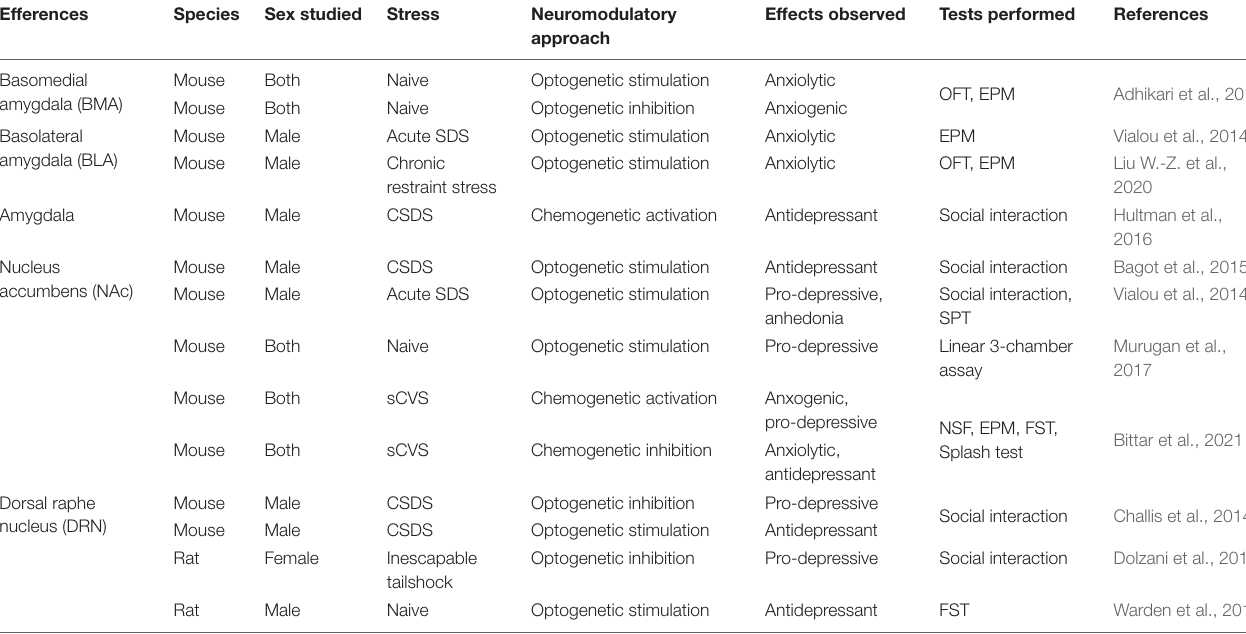
TABLE 2 | Overview of preclinical studies involving mPFC efferences in anxiety-like and depressive-like